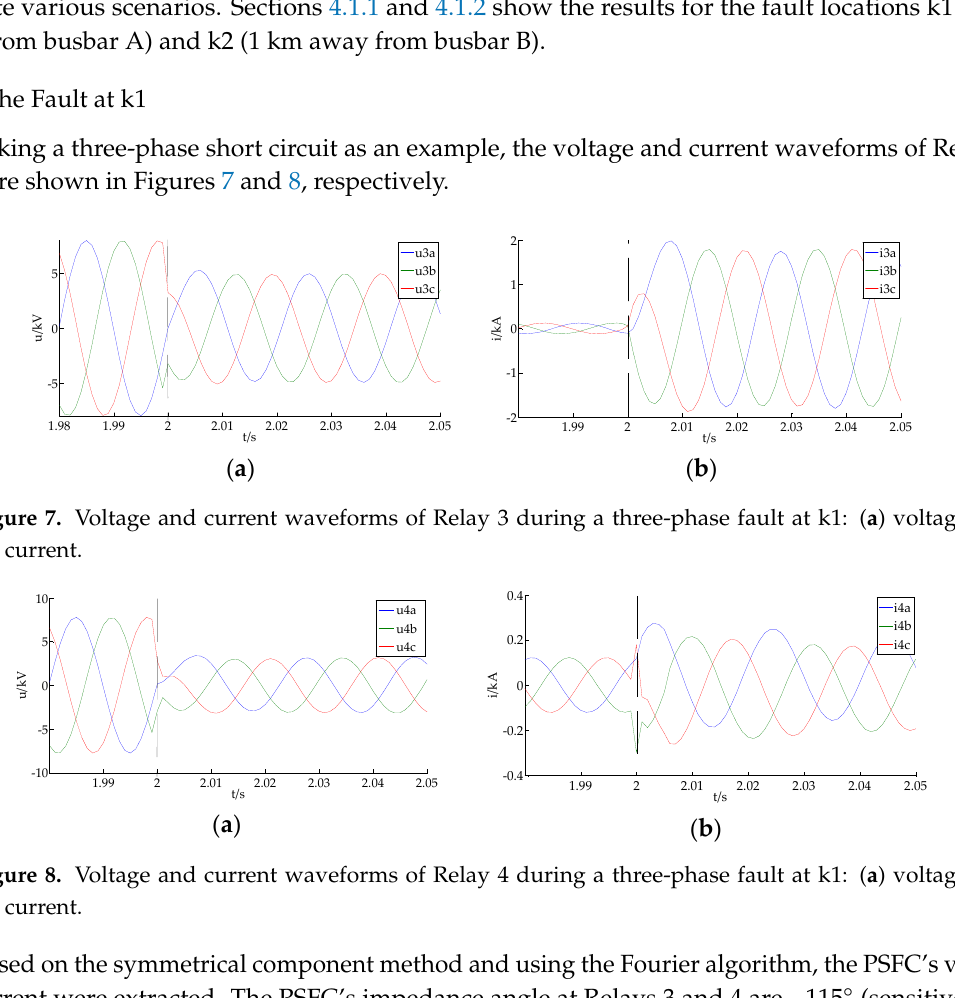
Figure 6. Flow chart of the improved directional relay.